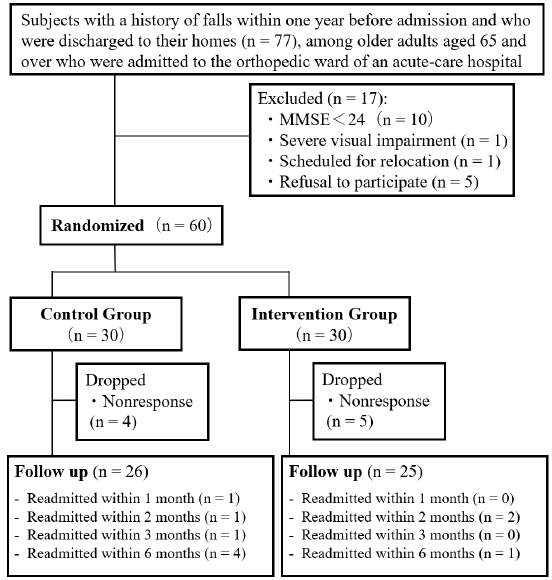
Figure 1. Assignment of subjects and flow chart. Note: MMSE, Mini-Mental State Examination.